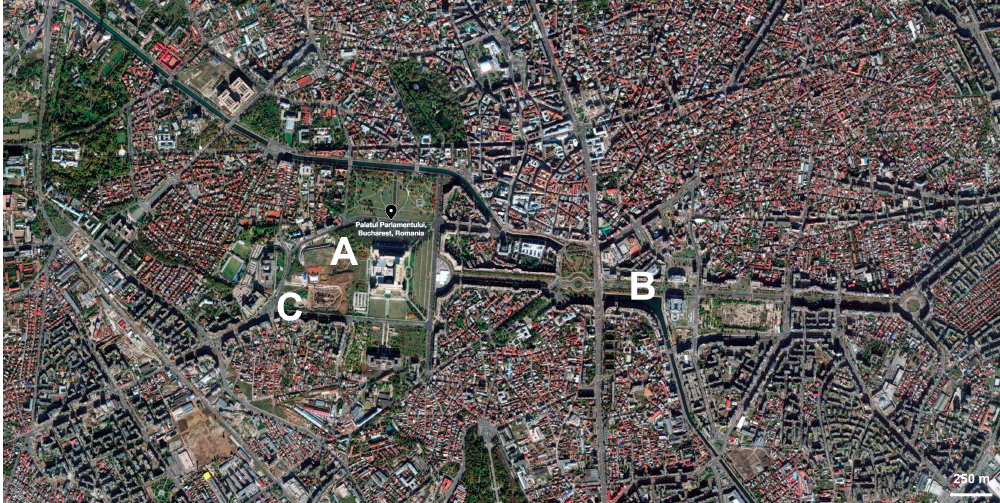
Figure 5. The dominating location of the Parliament Palace (A) in the center of Bucharest, accentuated with the axis running through Union Boulevard (B). Next to the Parliament Palace is the construction site for the People’s Salvation Cathedral (C). © 2018 Microsoft, © 2018 DigitalGlobe & © 2018 HERE. Source: http://www.bing.com/maps/, 2018-11-09.